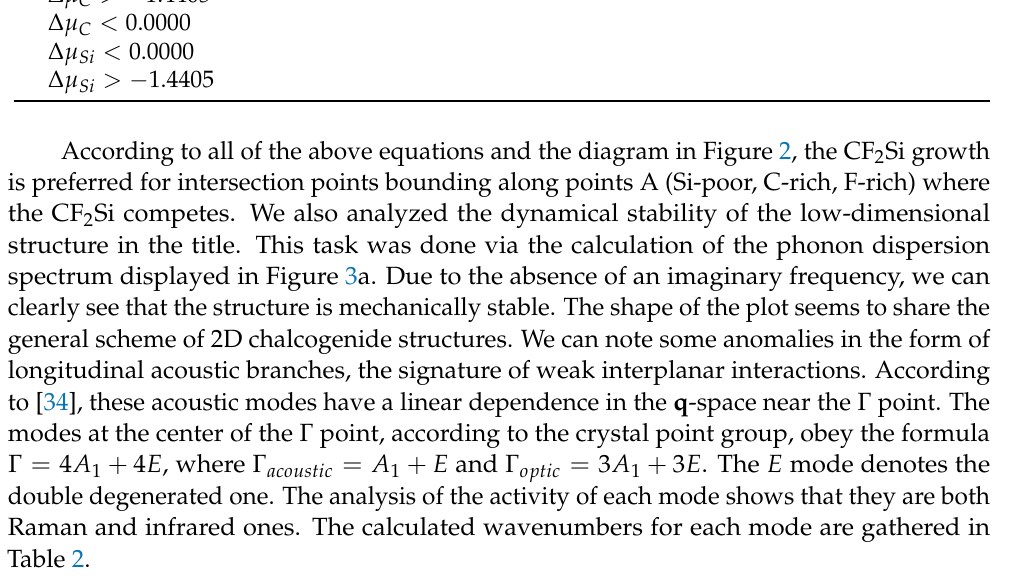
Table 2. Calculated modes of 2D CF 2 Si. Raman (R) and infrared (IR) modes are indicated.